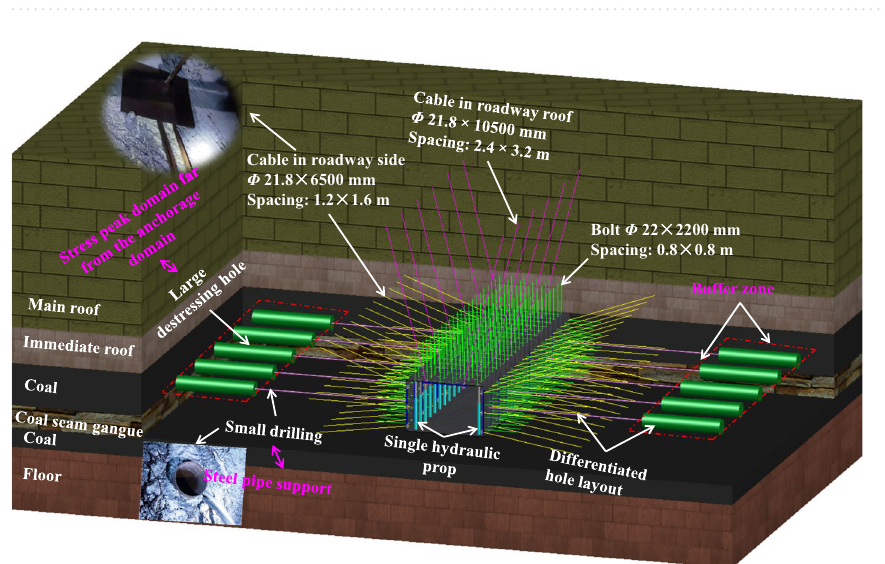
Figure 16. Three-dimensional drawing of comprehensive roadway protection technical